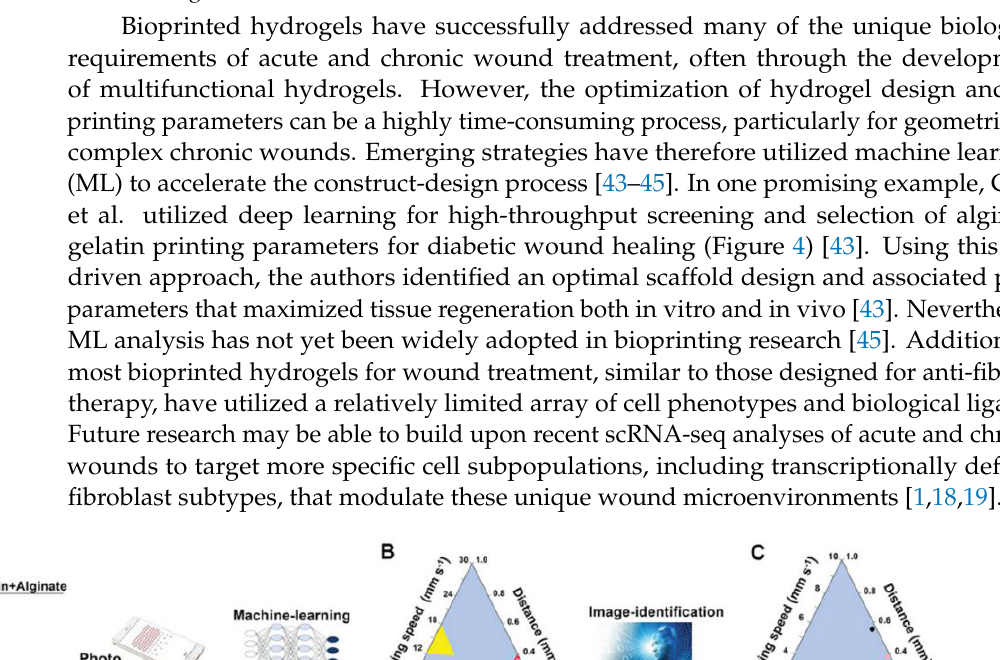
Figure 3. Bioprinting of geometrically complex hydrogel for chronic wound treatment, including conjugated polylysines for antibacterial effects and reduction of reactive oxygen species (ROS) at the wound site. Adapted with permission from [42], 2021, Wang et al.